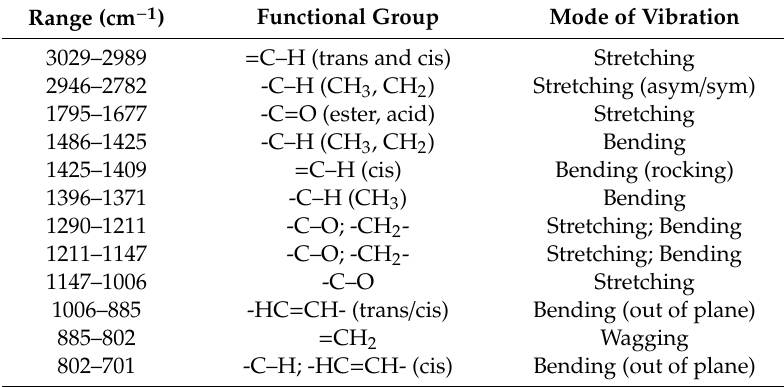
Table 2. FTIR wavenumber regions of vegetable oils, correlated with the mode of vibration for specific functional groups, considered as predictor variables for statistical data processing